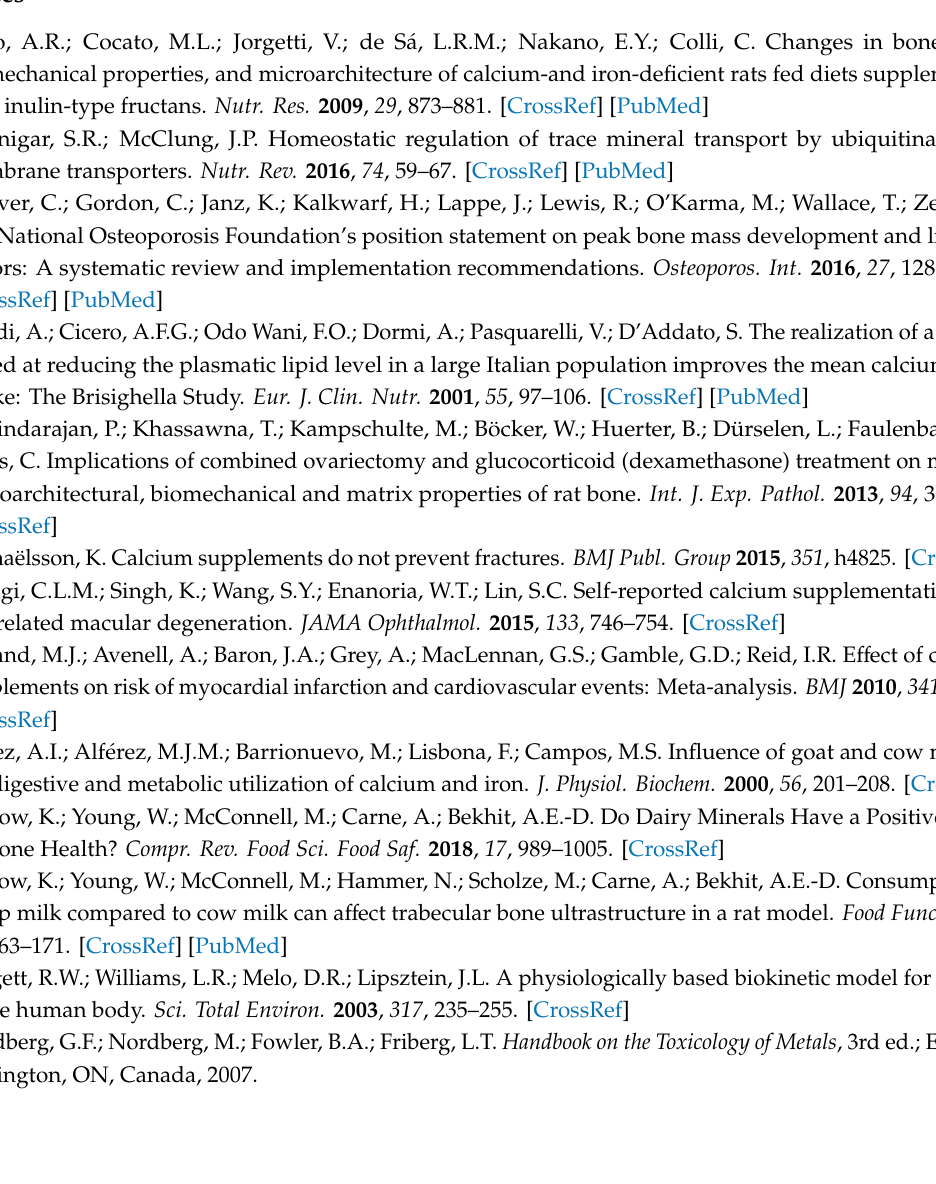
Table S1: Sheep milk, cow milk, modified-AIN-93M diet, and low Ca / P modified-AIN-93M diet mineral compositions as determined by ICP-MS; Table S2: µ -CT instrument operational parameters; Table S3: Detection limits for bone inductively coupled plasma–mass spectrometry (ICP-MS) analysis; Table S4: Parameters determined in cortical and trabecular bone using µ -CT